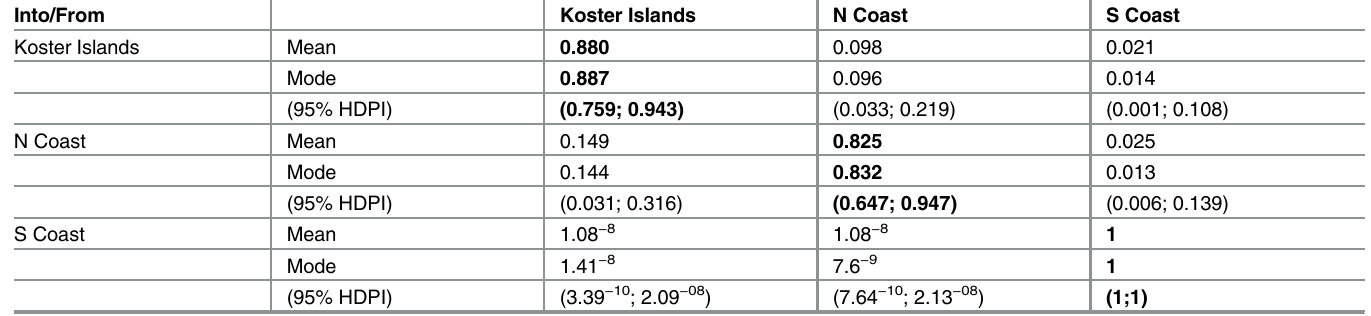
Table 4. Recent migration rate (Nm) of American mink between three sites in Sweden. Estimations are based on posterior means and modes calcu- lated by BIMR. Within-site movement is marked in bold. Into/From